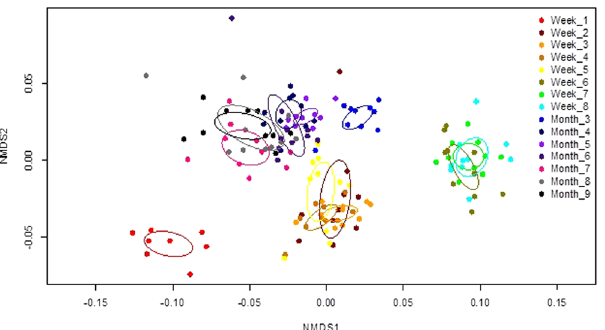
Figure 2. Lucilia sericata hydrocarbon profiles of puparial cases aged from 1 week to 9 months were visualized using a non-metric multidimensional scaling ordination based on a Bray-Curtis dissimilarity matrix and plotted on two dimensions (stress = 0.138, R 2 = 0.926); each puparial case age had a 95% confidence ellipses around class